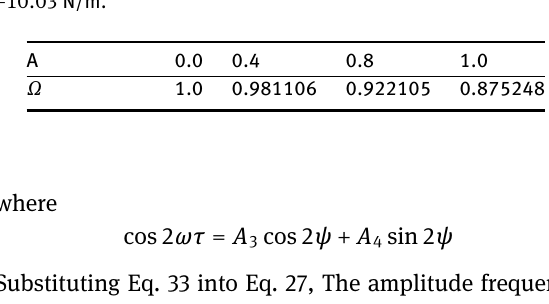
Table 3. The relationship between amplitude and frequency at E 0 = −10.03 N/m.